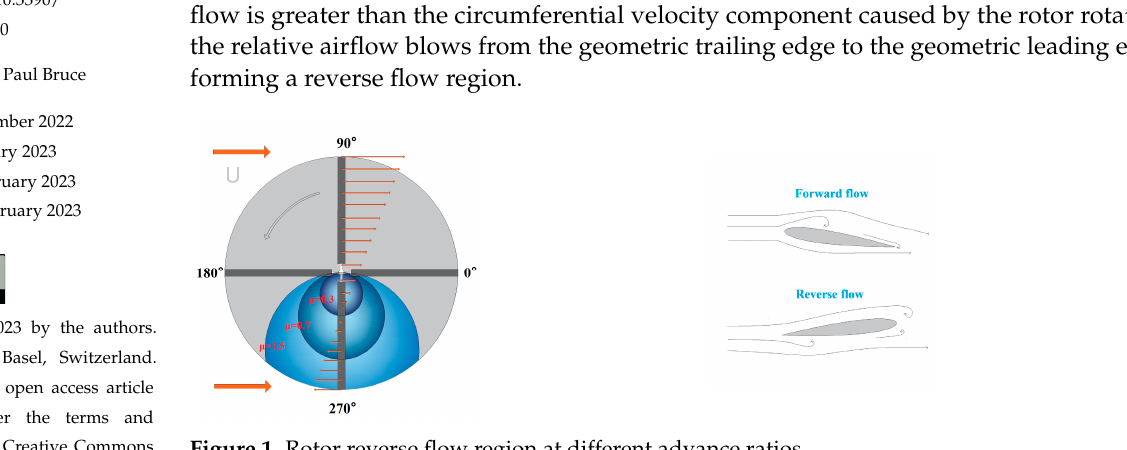
Figure 1. Rotor reverse flow region at different advance ratios.